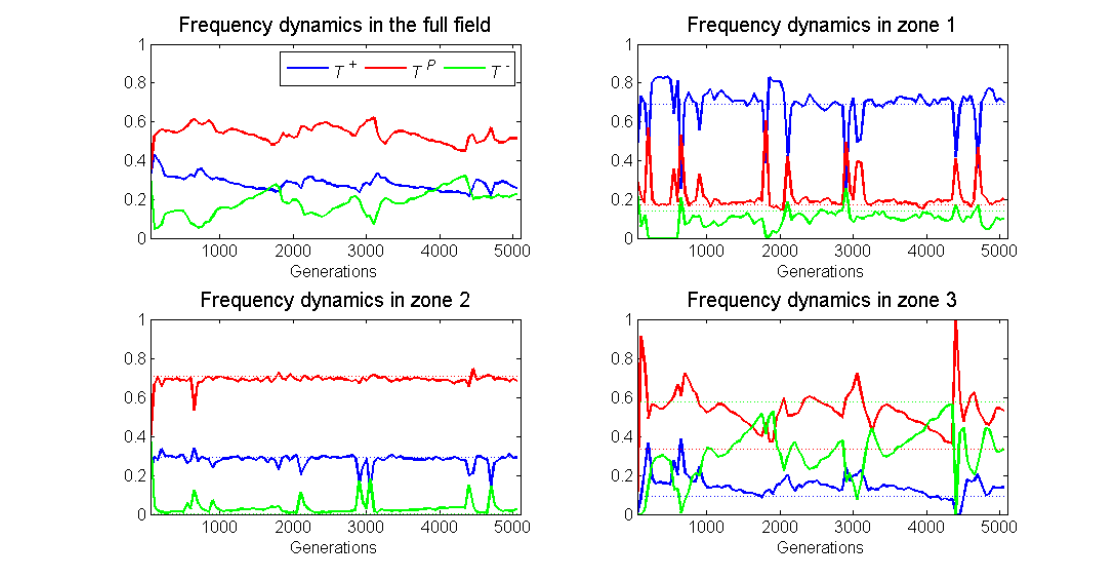
Figure 12. For dynamic blood vessels, frequency dynamics (of one run) of the spatial game for each of the three cell types: across the whole space ( top left ); in zone 1 ( top right ); in zone 2 ( bottom left ); and in zone 3 ( bottom right ). The blood vessel switches location with a low probability of 0.0025 per generation, neighborless cells can proliferate ( σ = 0.1), and the zones have a broad width ( r 1 = r 2 = r 3 = 5). Frequency dynamics are much sharper in zones 1 and 3 than in zone 2 because the overall frequency of cell types matches more closely that of zone 2.